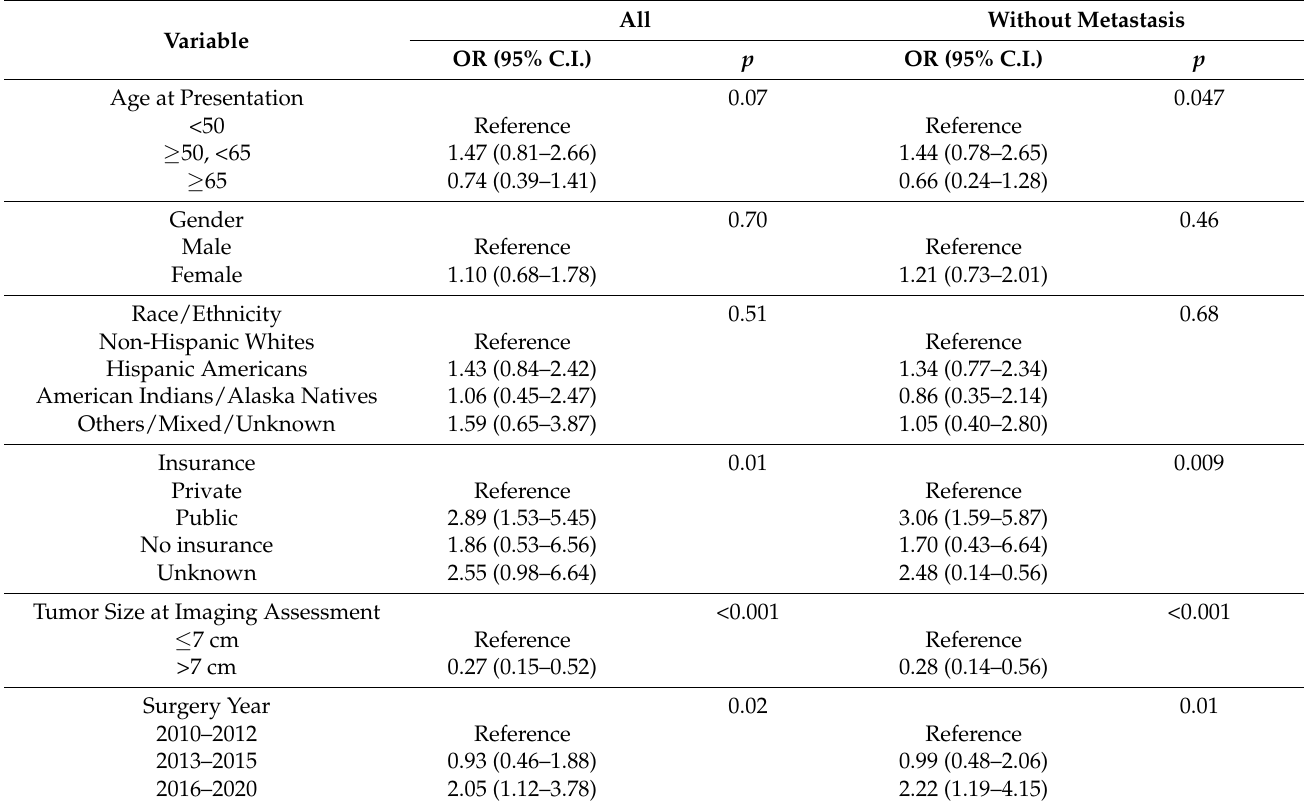
Table 3. Factors associated with more than 90 days SWT in a logistic regression